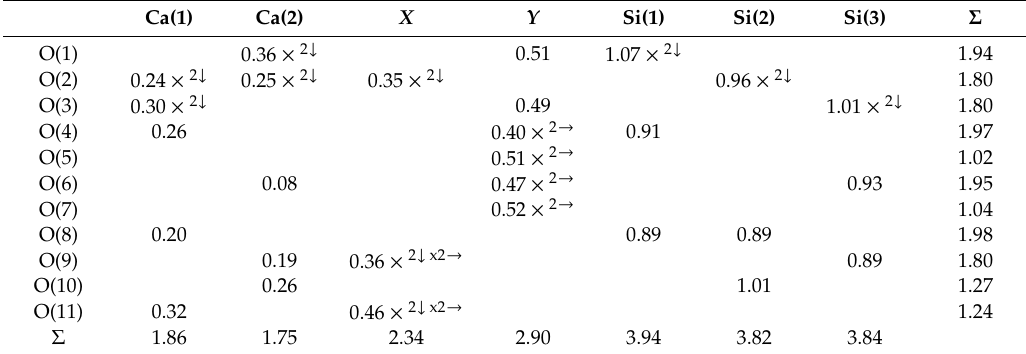
Table 6. Bond valence calculations 1 for shuiskite-(Cr).